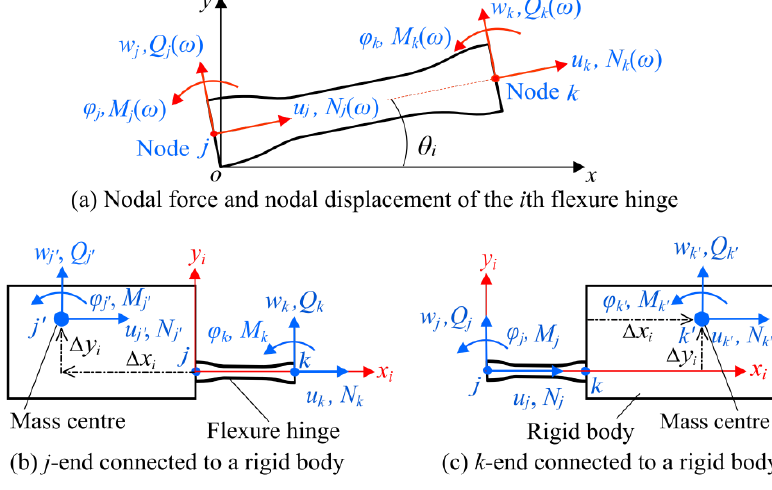
Figure 6. Nodal force and nodal displacement of flexure hinges/beams connected or not connected to a rigid body. ( a ) Nodal force and nodal displacement of the i th flexure hinge/beam in the reference coordinate frame o - xy . ( b ) The j -end is connected to a rigid body. ( c ) The k -end is connected to a rigid body.